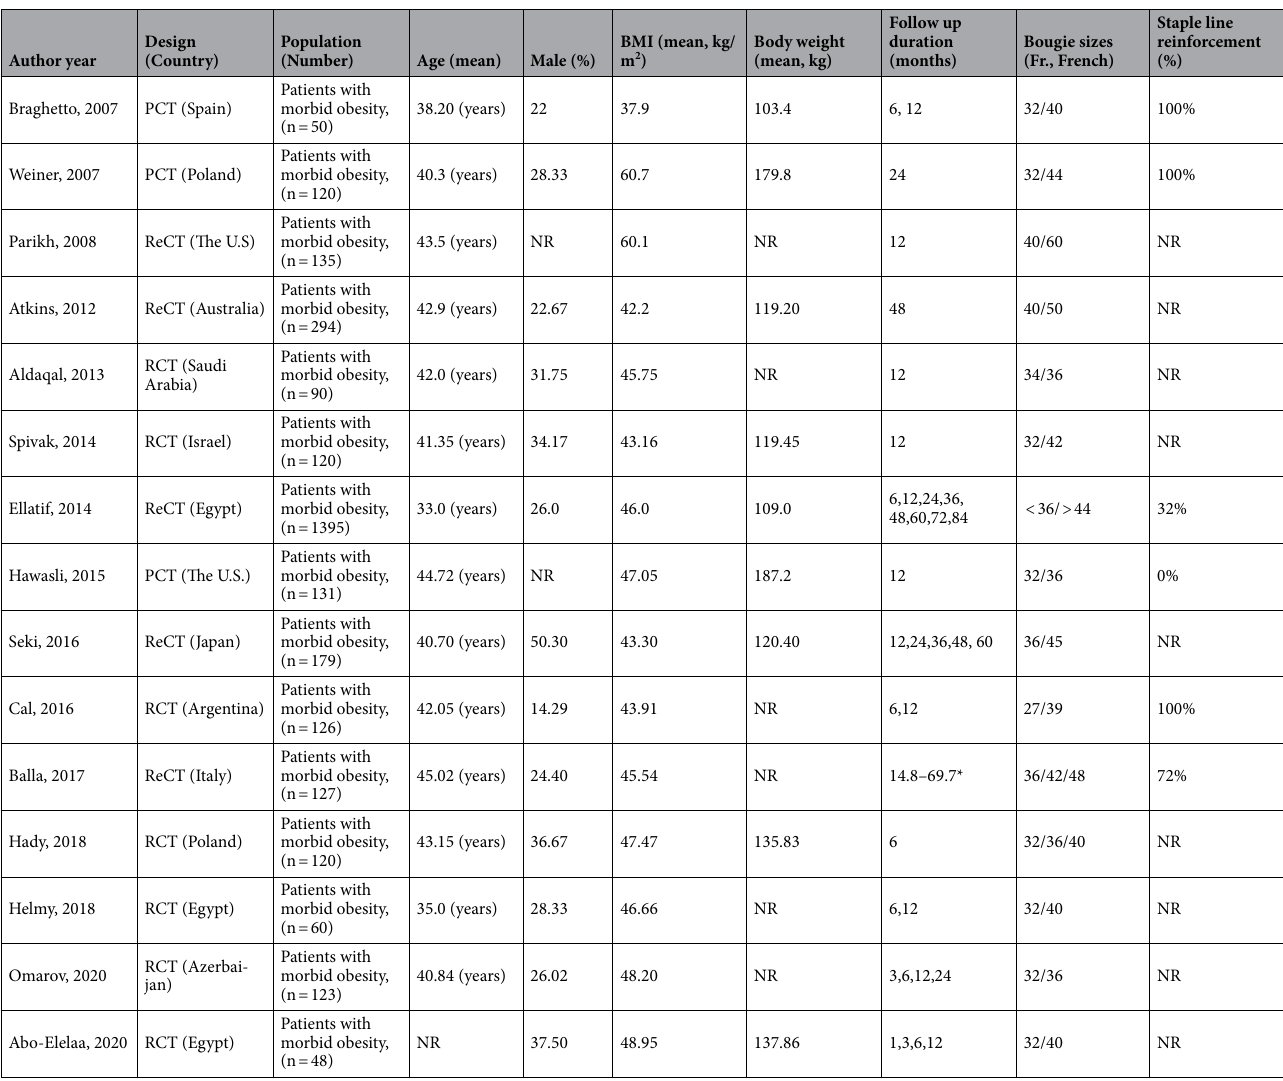
Table 1. Characteristic of enrolled studies. PCT = prospective cohort study; ReCT = retrospective cohort study; BMI = body mass index; RCT = randomized controlled trial; U.S. = United States; NR = not reported. *The range of following